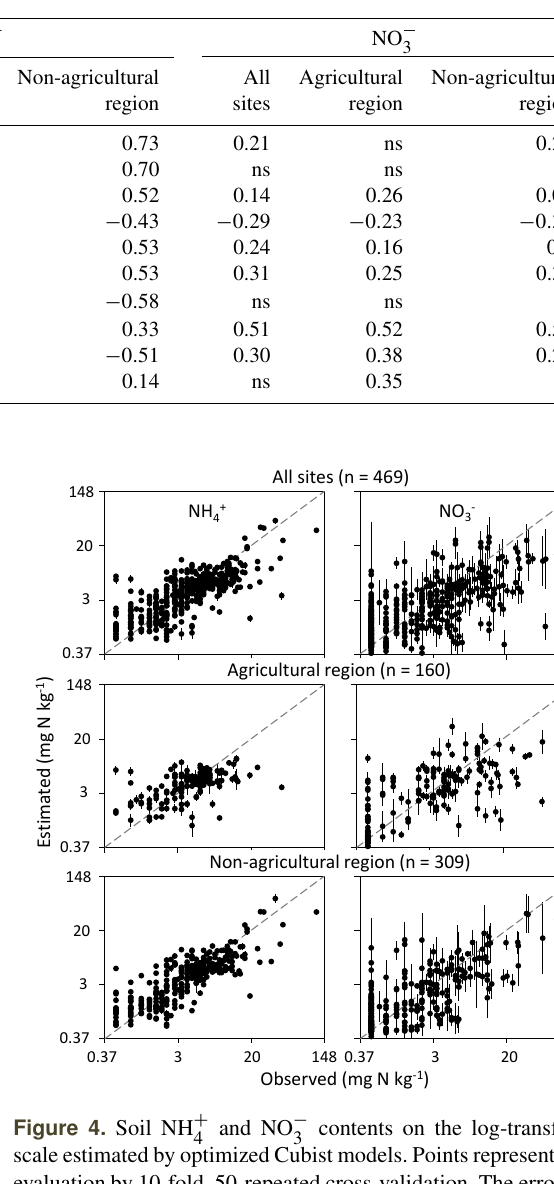
Table 2. Significant Pearson’s correlation coefficients between soil NH ( n = 469). The correlations indicated by “ns” are not significant.